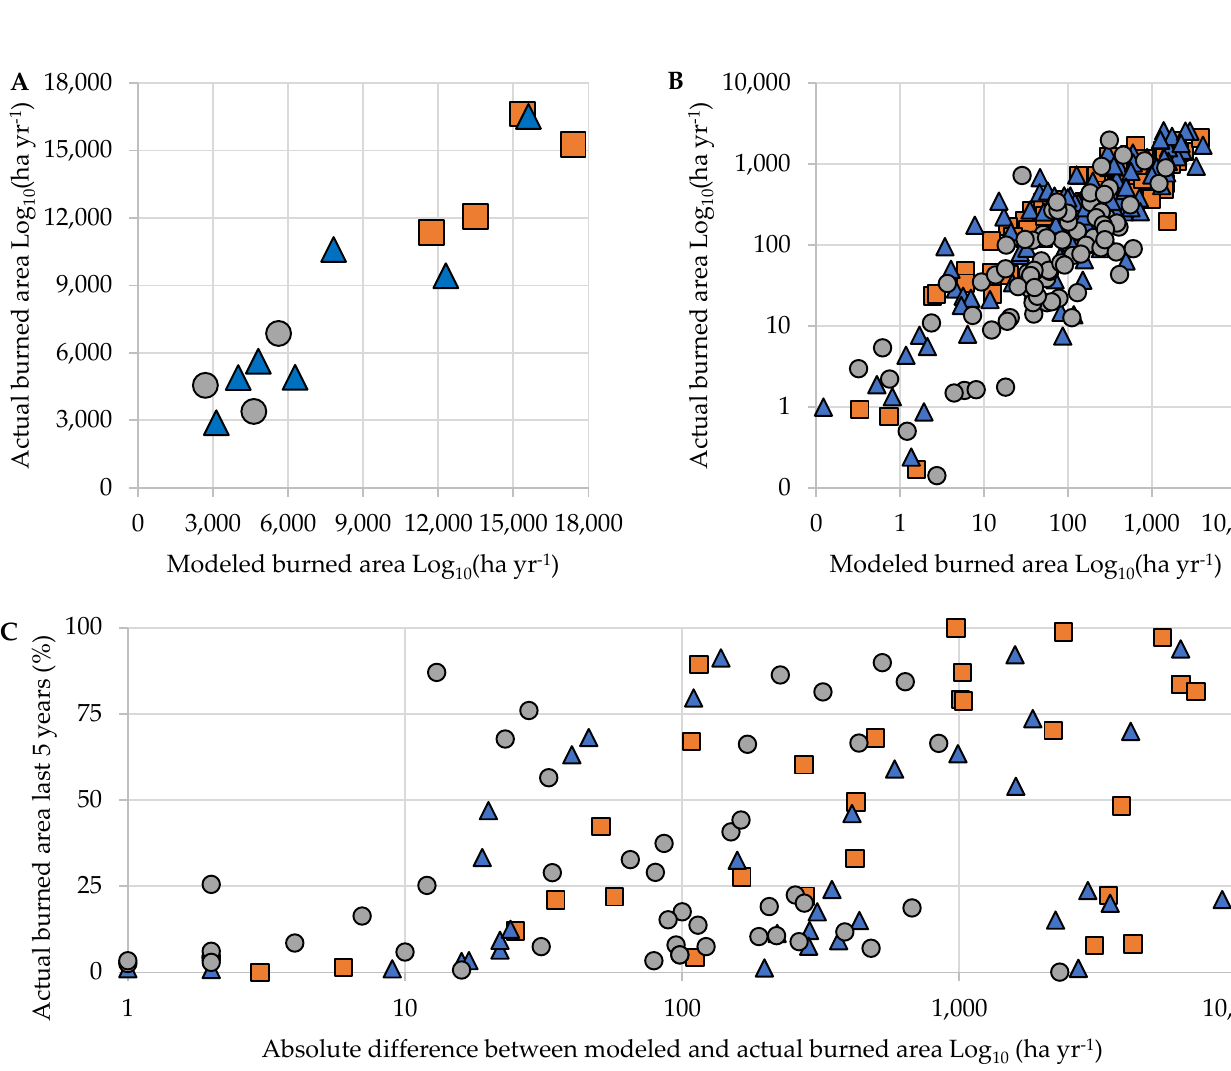
Figure 3. Actual and modeled burned area (ha yr −1 ) by macro-area ( A ) and community ( B ), and community-level percentage area burned in the last five years vs. the absolute difference between the modeled and actual burned area ( C ). The burned areas were calculated using modeled annual burn probability (Figure 2B) and empiric burn probability grids.